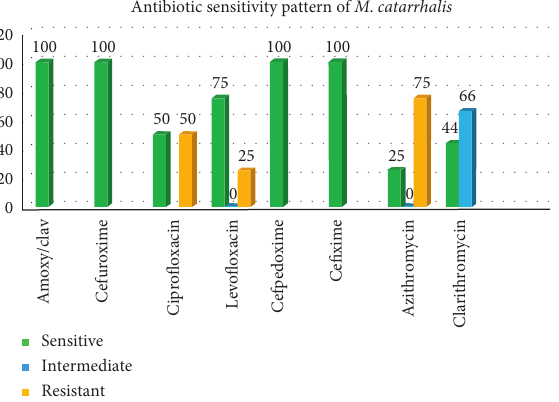
Figure 5: Antibiotic sensitivity pattern of M. catarrhalis .